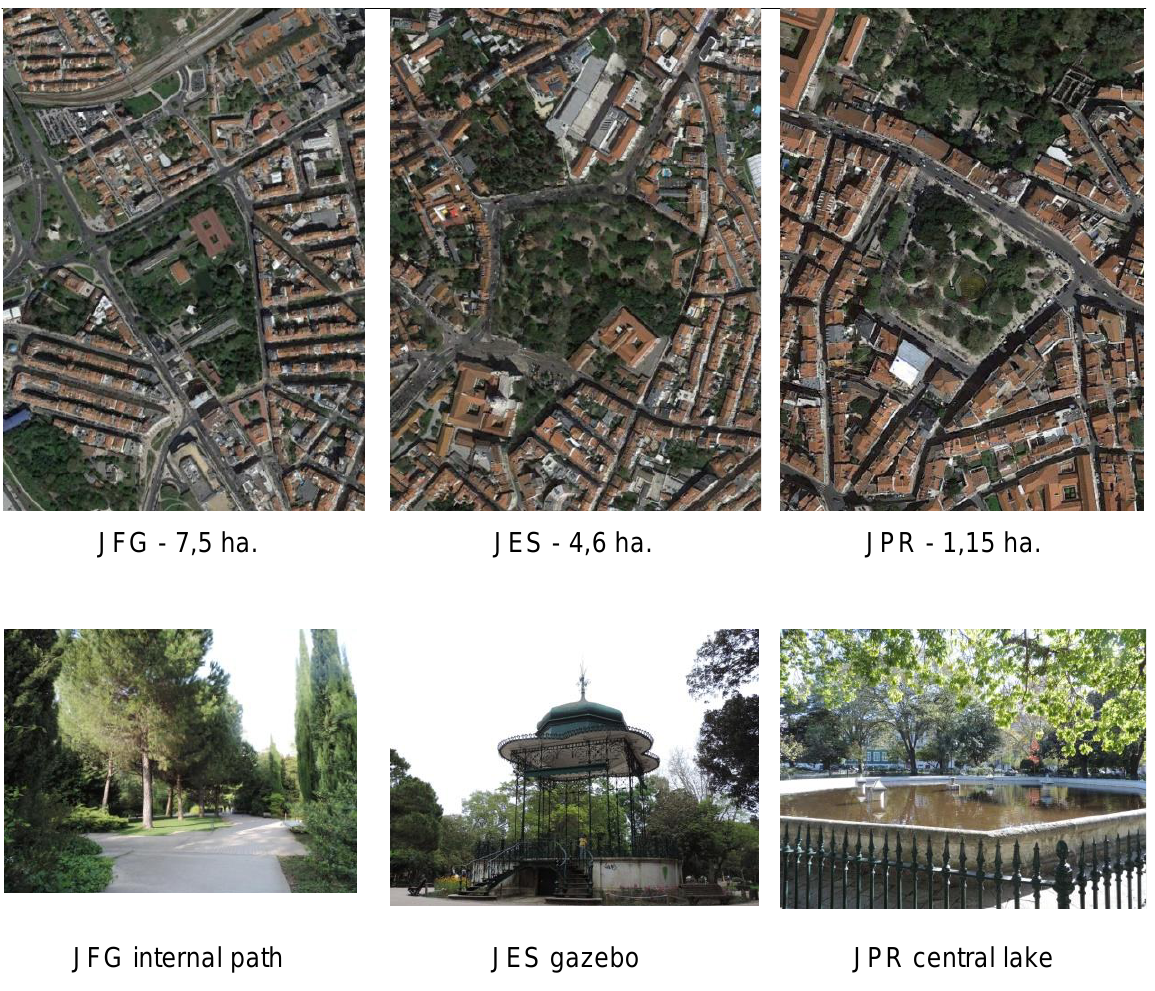
Figure 1: Urban parks in Lisbon; JFG = Calouste Gulbenkian Foundation Garden; JES = Estrela Garden; JPR = Príncipe Real Garden.